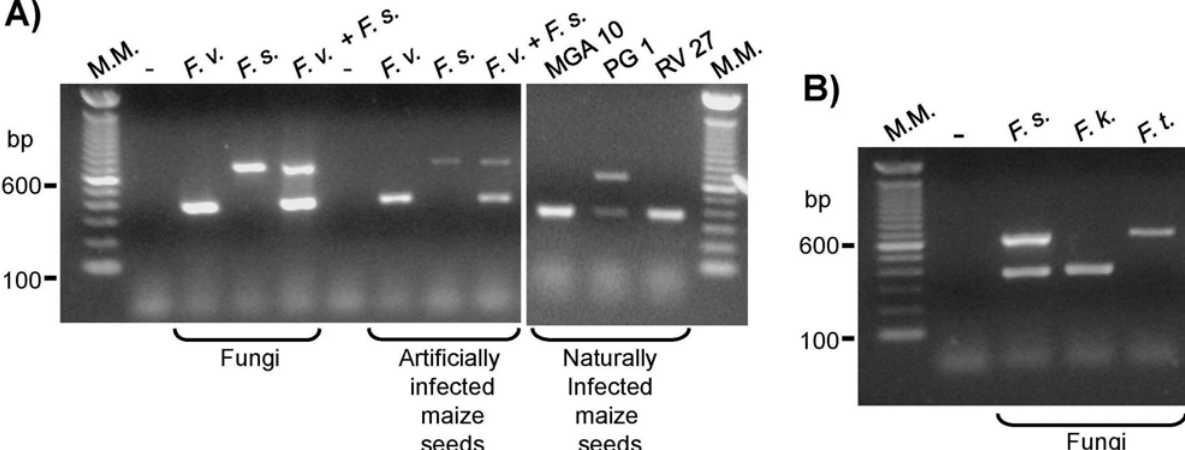
Figure 4. Multiplex PCR reactions. ( A ) A multiplex PCR reaction for the simultaneous detection of F. verticillioides and F. subglutinans . The PCR reactions were performed with FV-F2/FV-R and FS-F1/FS-R primer pairs and the genomic DNA of only F. verticillioides (50 ng), only F. subglutinans (50 ng), or of F. verticillioides (25 ng) together with F. subglutinans (25 ng). The genomic DNA (50 ng) extracted from mycelia of fungi growing on the top of and around cultured maize seeds that were artificially or naturally contaminated (MGA 10, PG 1, and RV 27 seed lots) was also used in the reaction. ( B ) The multiplex reactions with primer pairs FS-F2/FS-R and SUB1/SUB2 [14] to identify F. subglutinans , F. thapsinum , and F. konzum . M.M. indicates the 100-bp molecular marker from Invitrogen (USA). ( − ) indicates the negative control reaction in which no DNA was added. F. v. is Fusarium verticillioides CML 767. F. s. is F. subglutinans